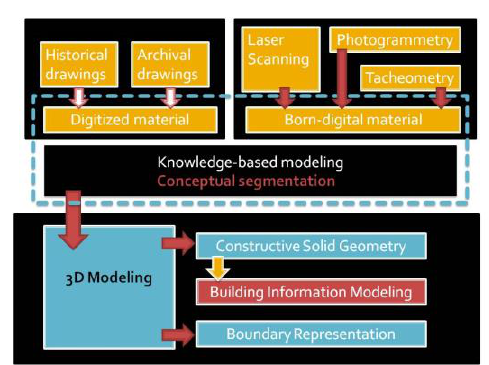
Figure 4. Extensive pipeline of spatial data